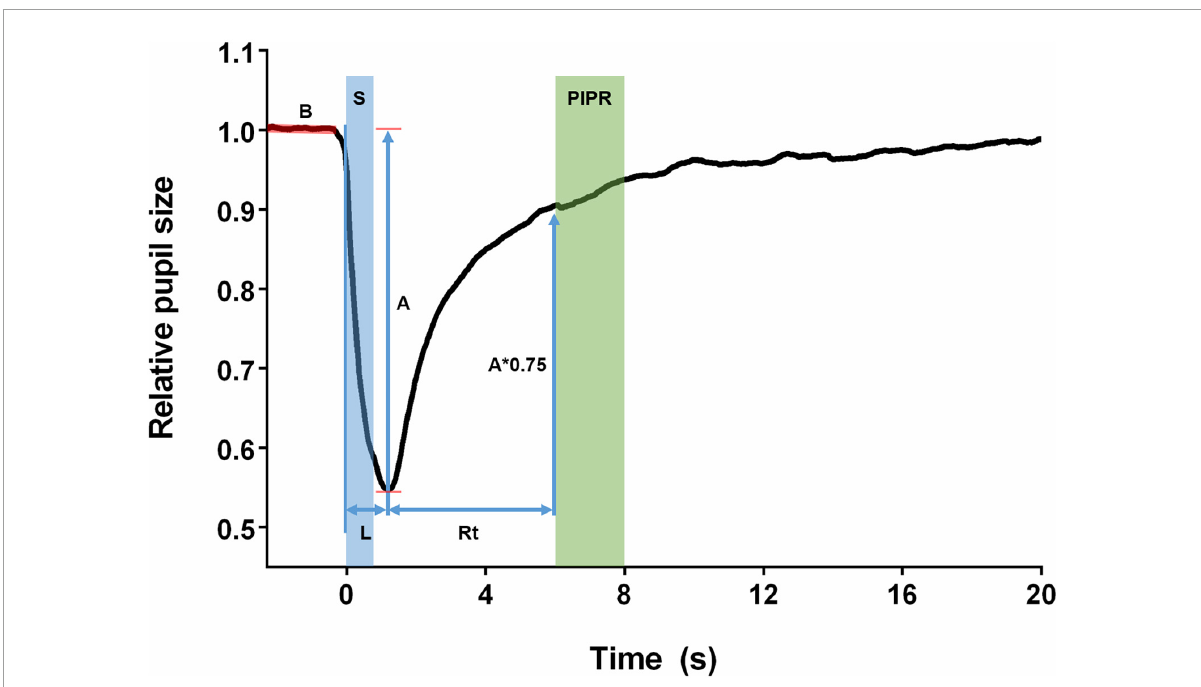
FIGURE1 Features of the pupillary light reflex. The baseline (B) was obtained as the median of the pupil size of the 3 s before the stimuli. The stimulus (S) was presented as a step of light with 1-s duration. Amplitude (A) was defined as the maximum constriction reached by the pupil after the stimulus. Latency (L) was the time between the beginning of the stimulus and the moment when the pupil reached its maximum constriction. Recovery time was calculated from the pupil maximum constriction until the pupil had returned to 75% of its baseline size (A*0.75). The post-illumination pupil response (PIPR) was calculated as the median pupil size recorded in the period of 6–8 s after the start of the stimulus.